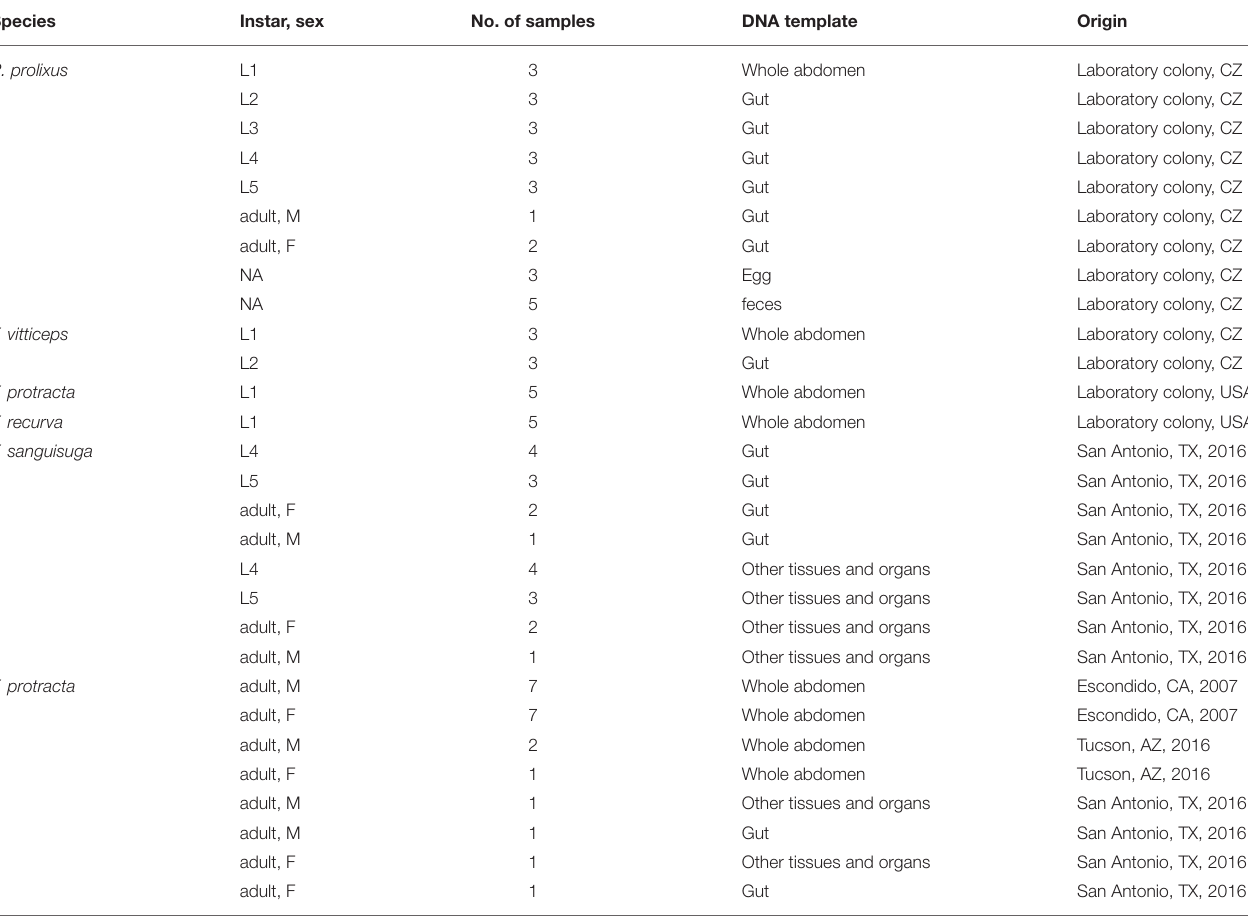
TABLE 1 | List of all the DNA isolates for which the 16S rRNA gene amplicon data were generated in this study.